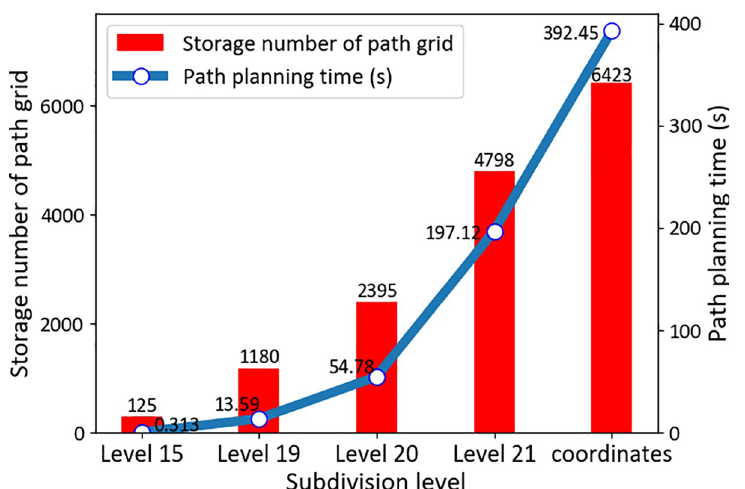
Fig 7. Time and storage consumption for path planning. In an identical airspace, with the same starting and ending points, this paper uses different environmental modeling methods to plan a UAV’s trajectory under the 5G field. The path planning time refers to the computing time required for a UAV to use the improved A � algorithm to obtain the optimal path. The storage number of the path grid refers to the number of trajectory grids generated in different environment modeling